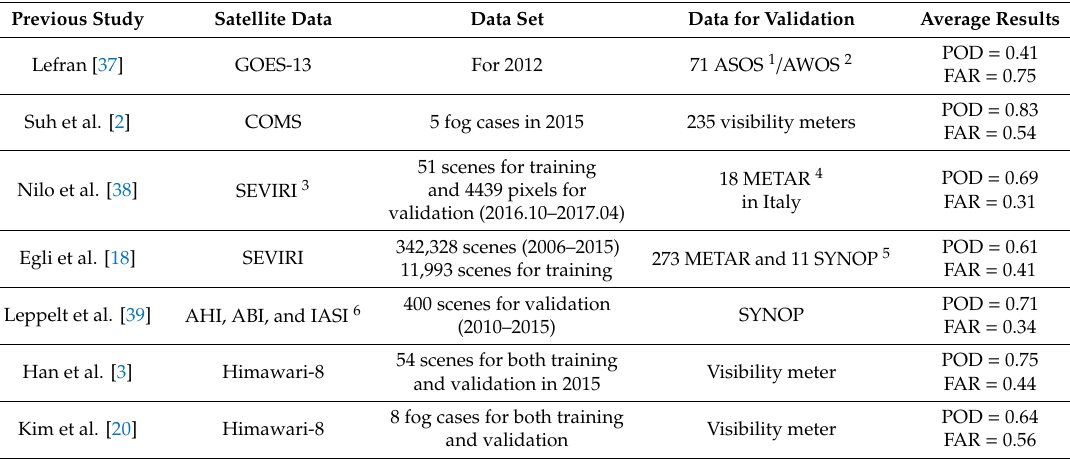
Table 7. Summary of the validation results using ground observation data of previous studies